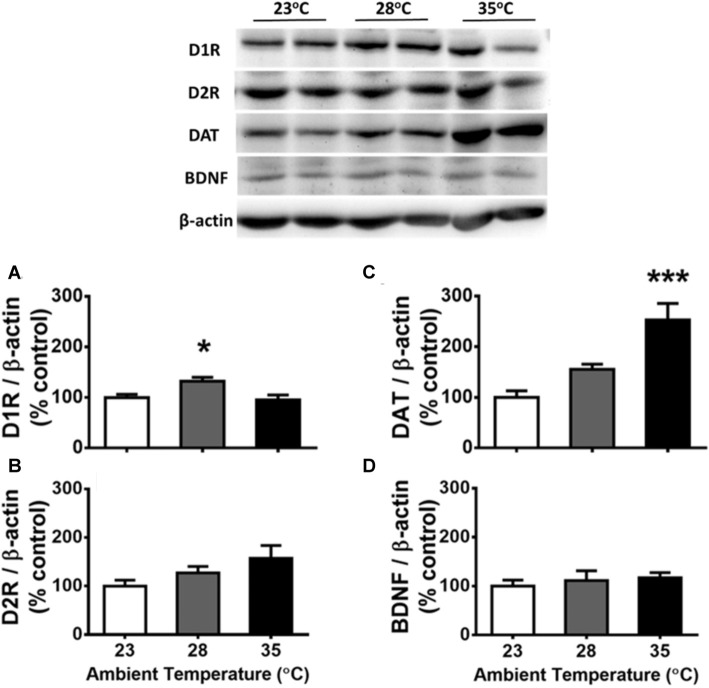
Protein levels of D1 receptors (D1Rs; A), D2Rs (B), DA reuptake transporters (DATs; C), and brain-derived neurotrophic factor (BDNF; D) in the dorsal hippocampus (dHIP) following the exposure of high ambient temperatures (n = 6 per group). Representative protein pattern profiles depicting the changes of these four proteins in high ambient temperatures are shown on the top panel. All data are displayed as mean ± SEM. *p < 0.05 and ***p < 0.001 as compared with the control group of 23°C (Bonferroni test).